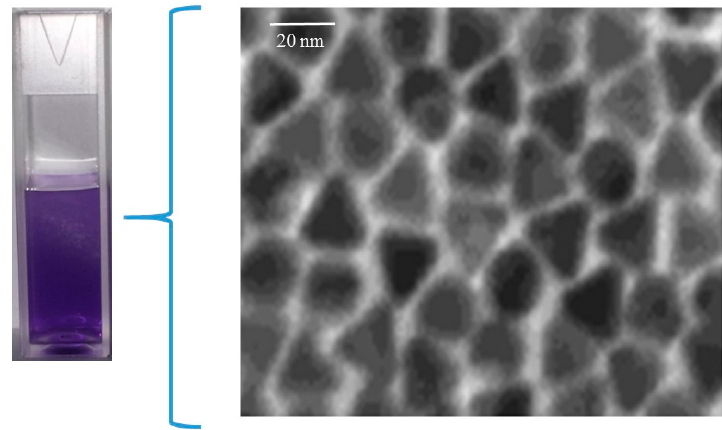
Figure 3. Photograph of uncoated prismatic nanoparticles in aqueous suspension ( left ), and TEM image of a sample ( right ).